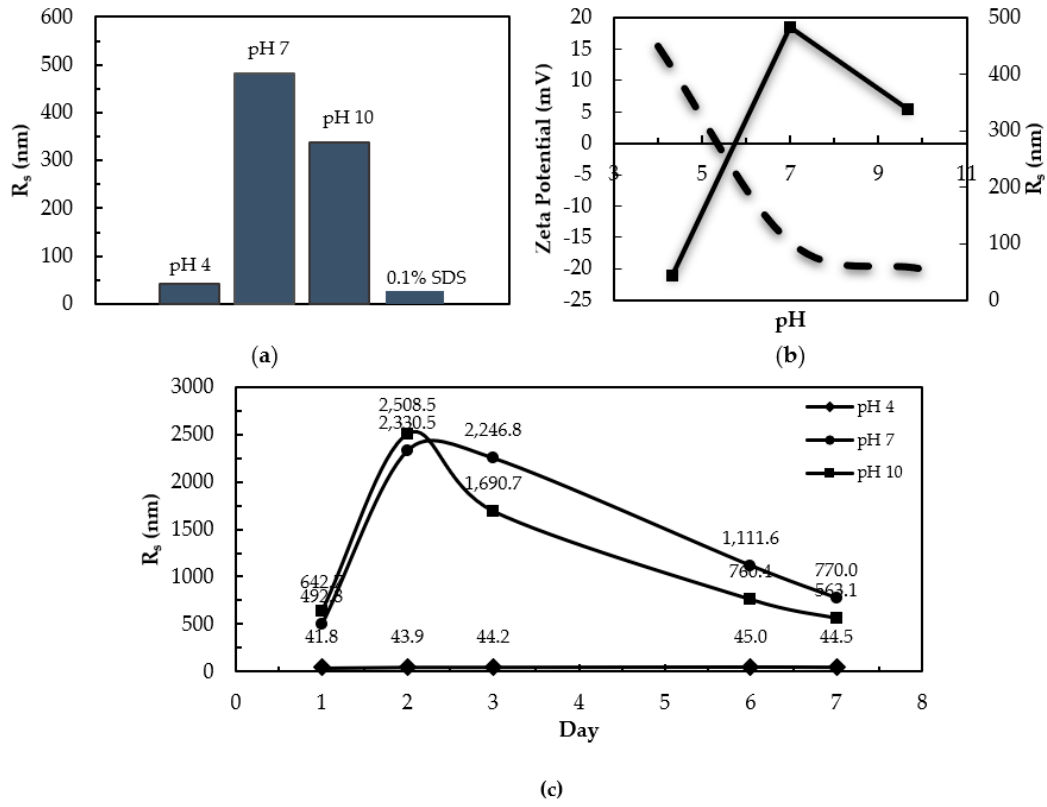
Figure 4. ( a ) Measured R s of cl-Par-4 under native and denaturing conditions by Dynamic Light Scattering (DLS). ( b ) Relationship of zeta potential (dashed) to pH and R s (solid line). ( c ) Measured R s over seven days at pH 4, 7, and 10.